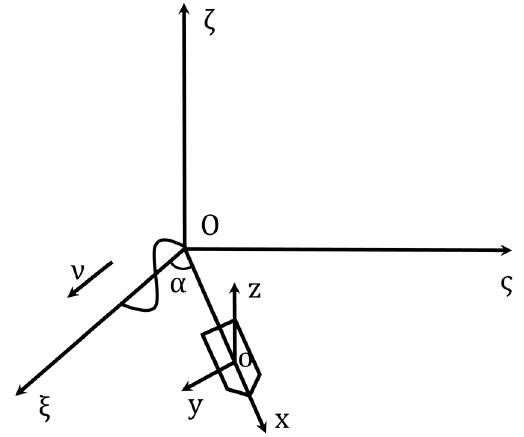
Figure 1. The coordinate diagram of floating platform.